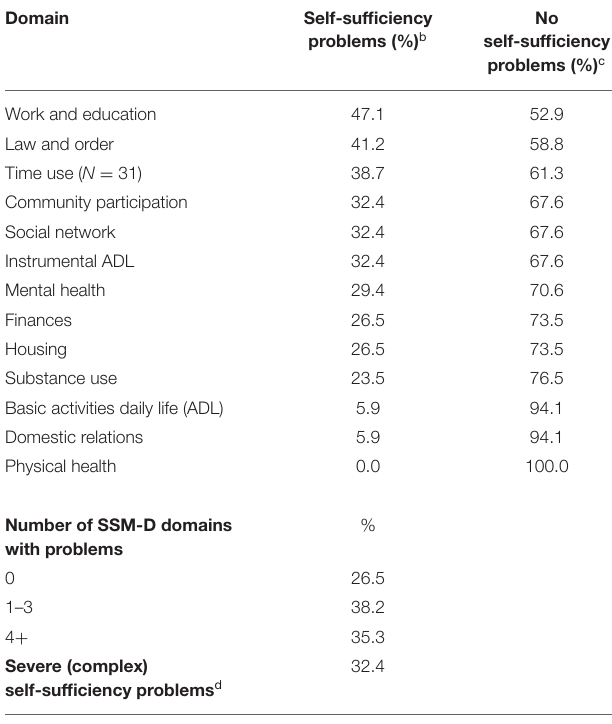
TABLE 5 | Prevalence estimates of distinct childhood adverse experiences and mean ACE score in subjects ( N = 34) included in a case-based approach of radicalization in Amsterdam (January